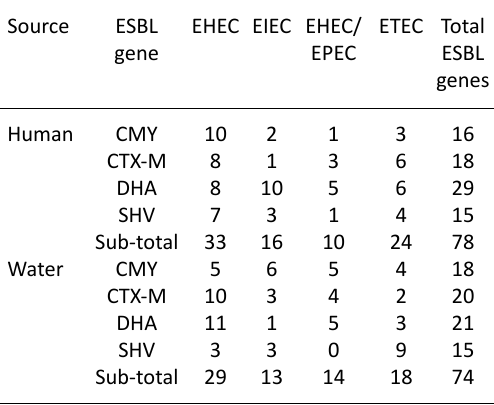
Table 6. Distribution of ESBL genes among the E. coli pathotypes